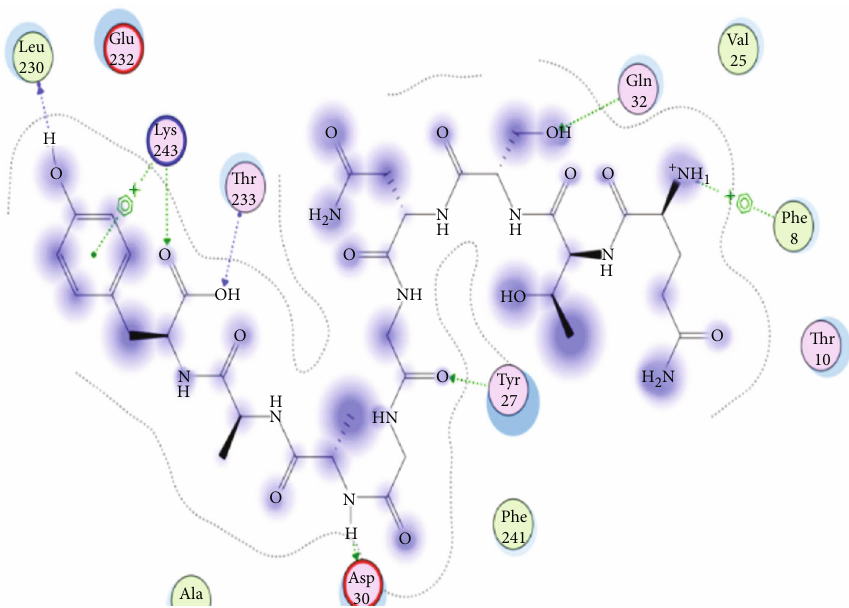
Figure 14: Illustration of the 2D interaction of the best docking poses of QTSNGGAAY in the binding sites of HLA-A ∗ 02:06.